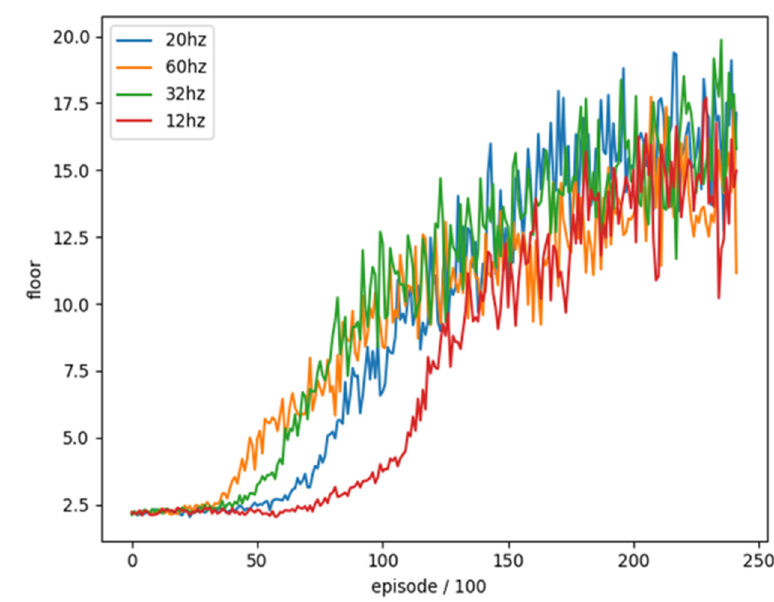
Figure 9. The training trend of sample frequency.